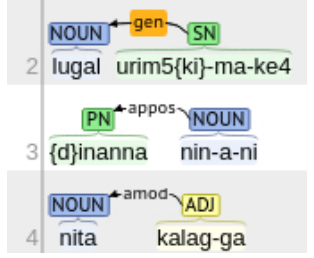
Figure 3. Brat annotation